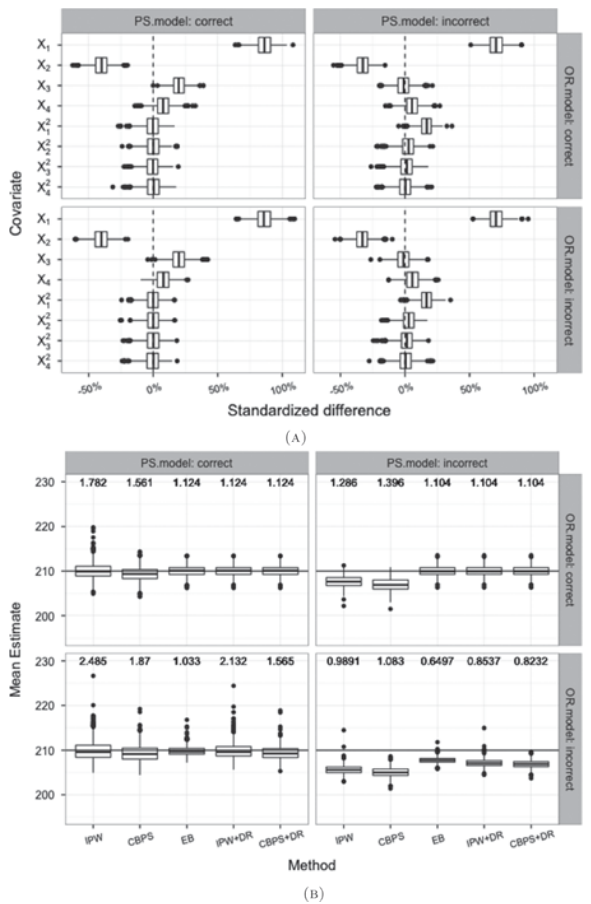
Figure 3: Kang-Schafer example: sample size u = 200 . Both propensity score model and outcome regression model can be correct or incorrect, so there are four scenarios in total. We generate 1,000 simulations in each scenario. (a) Covariate imbalance before adjustment. (b) Mean estimates. The methods are: Inverse Propensity Weighting (IPW), Covariate Balancing Propensity Score (CBPS), Entropy Balancing (EB), and doubly robust versions of the first two (IPW+DR, CBPS+DR). Target mean is 210 and is marked as a black horizontal line to compare the biases. Numbers printed at Y = 230 are the sample standard deviations to compare